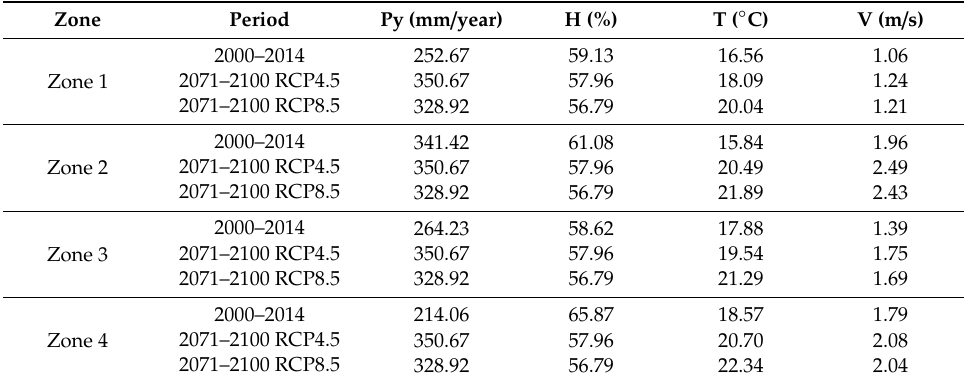
Table 5. Comparison of average meteorological data between available historical wildfire data from the period 2000–2014 and future climate change scenarios data (RCP4.5 and RCP8.5) during the period (2071–2100) (Py is average yearly rainfall, H is humidity, T is temperature, and V is wind velocity).